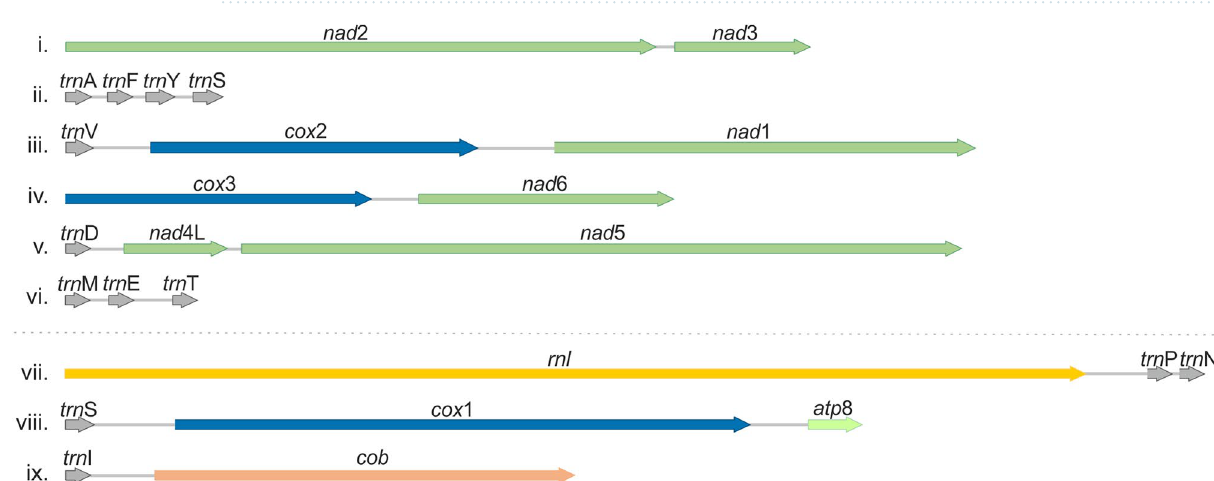
Figure 2. The main syntenic units of Malassezia mitogenomes. The first six units can be found in all Malassezia spp. (i.e., i–vi) while the last three in all except M. cuniculi (i.e., vii–ix). Arrows indicate gene transcription